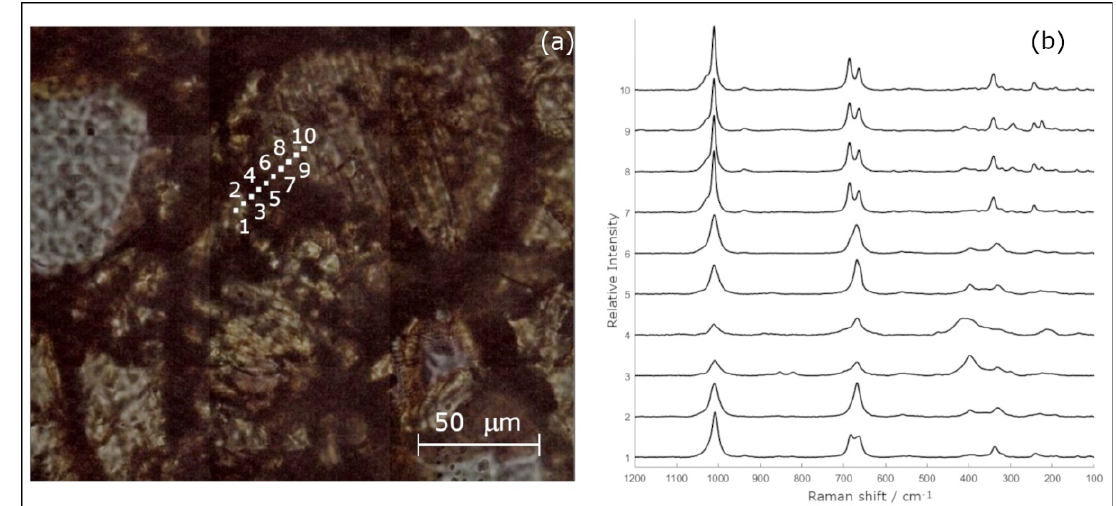
Figure 4. Line spots Raman mapping: ( a ) OM plane-Polarised Transmitted Light acquired by 100× objective in montage mode, where the position of the 10 spots analyses have been reported; ( b ) the 10 Raman spectra corresponding to the spots indicated in ( a ). A step of 5 µm between the different spots has been set to perform the line mapping. The spectra acquired on 1, 7, 8, 9, and 10 spots correspond to the enstatite phase, while the analyses carried out from the rime (2, 5, and 6) show bands compatible with the diopside phase. Finally, the spectra from the matrix (3 and 4) show the spectral features of the diopside plus broad bands centred around 400 and 220 cm − 1 . It must be also noted the absence of any doublet bands at about 475–510 cm − 1 .